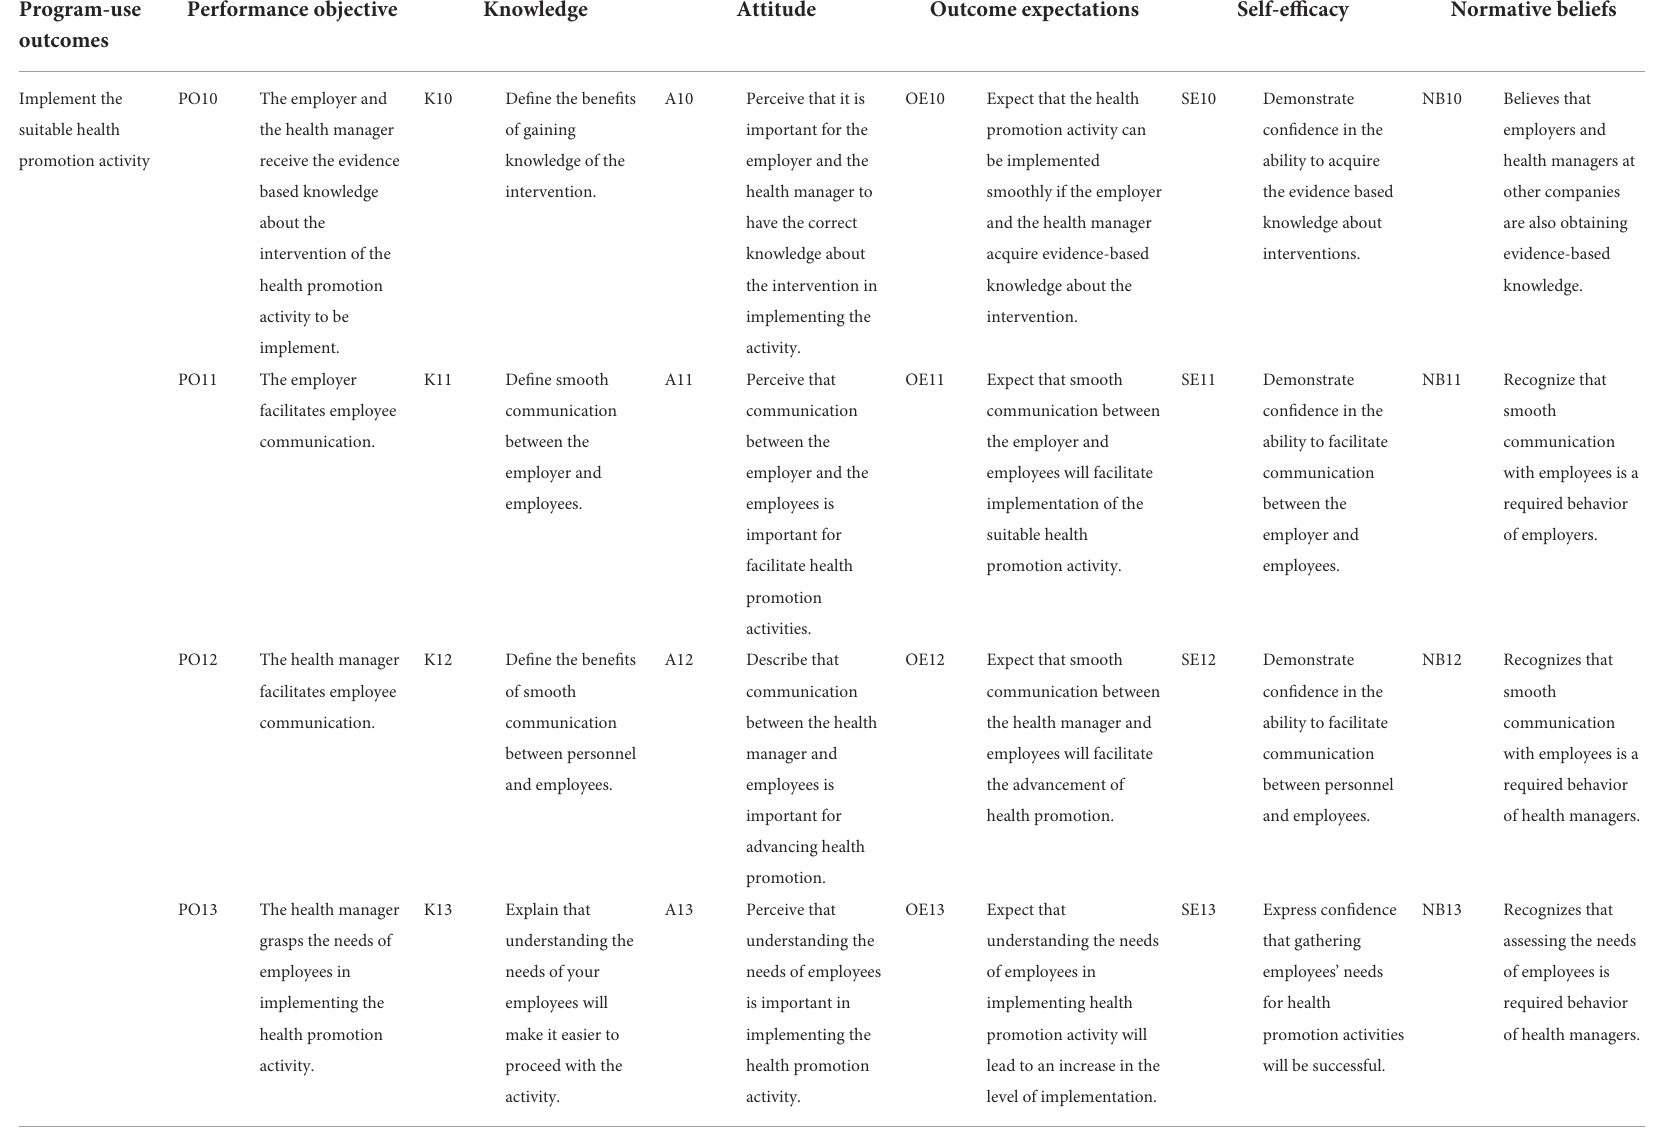
TABLE 2 Implementation Mapping process Task 2: